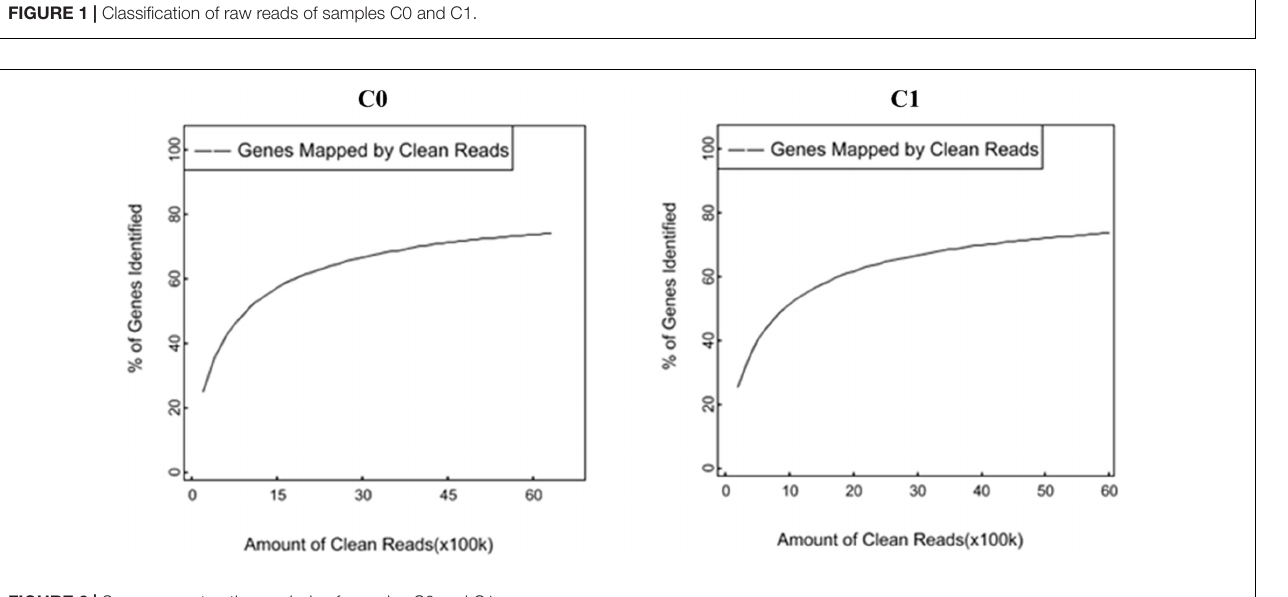
FIGURE 1 | Classification of raw reads of samples C0 and C1.